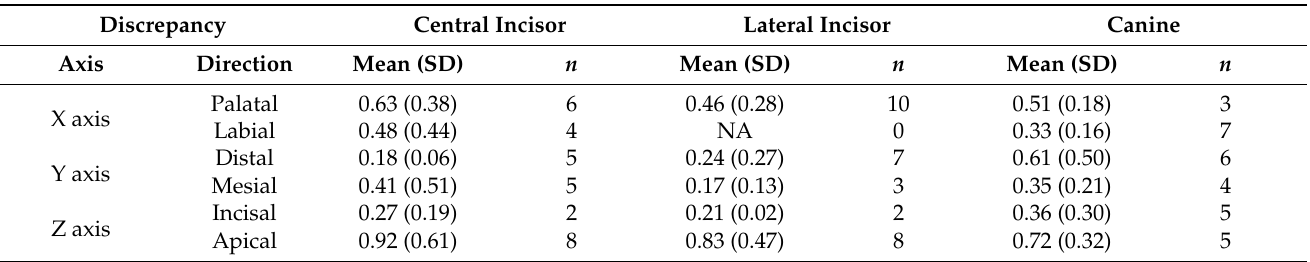
Table 2. The average root displacement of each tooth type on the X, Y, and Z axes and in six directions. There was no significant difference among the three tooth types.